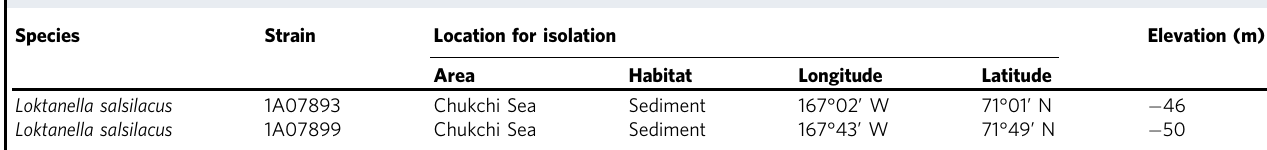
Table 1 Information of the two L. salsilacus strains applied in the present study. Species Strain Location for